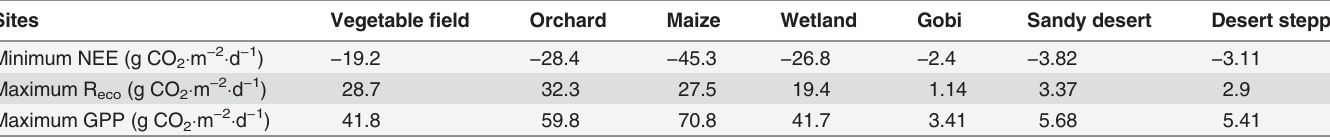
Table 1. Maximum GPP , R eco , and Minimum NEE for different ecosystems during the observation period (June 10 — September 14, and, in wetland, June 26 — September 14). Sites Vegetable fi eld Orchard Maize